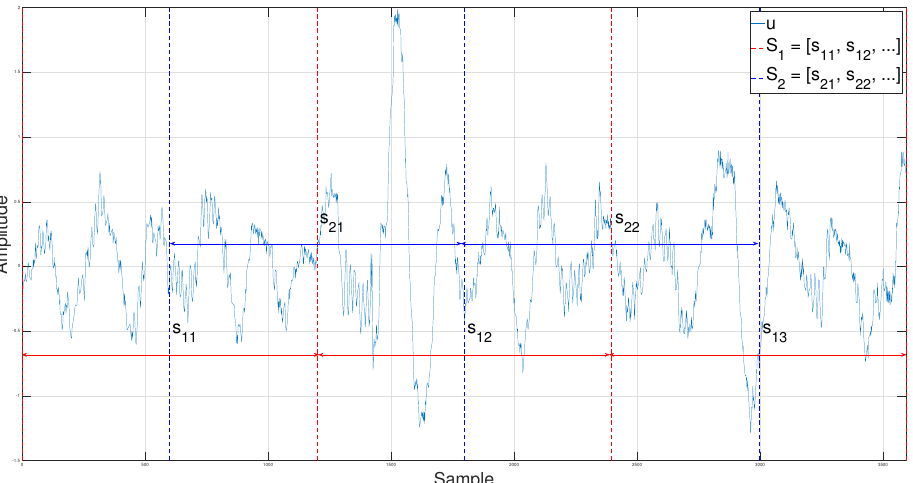
Figure 12. Decomposition of signal u into sub-datasets for the oscillation identification